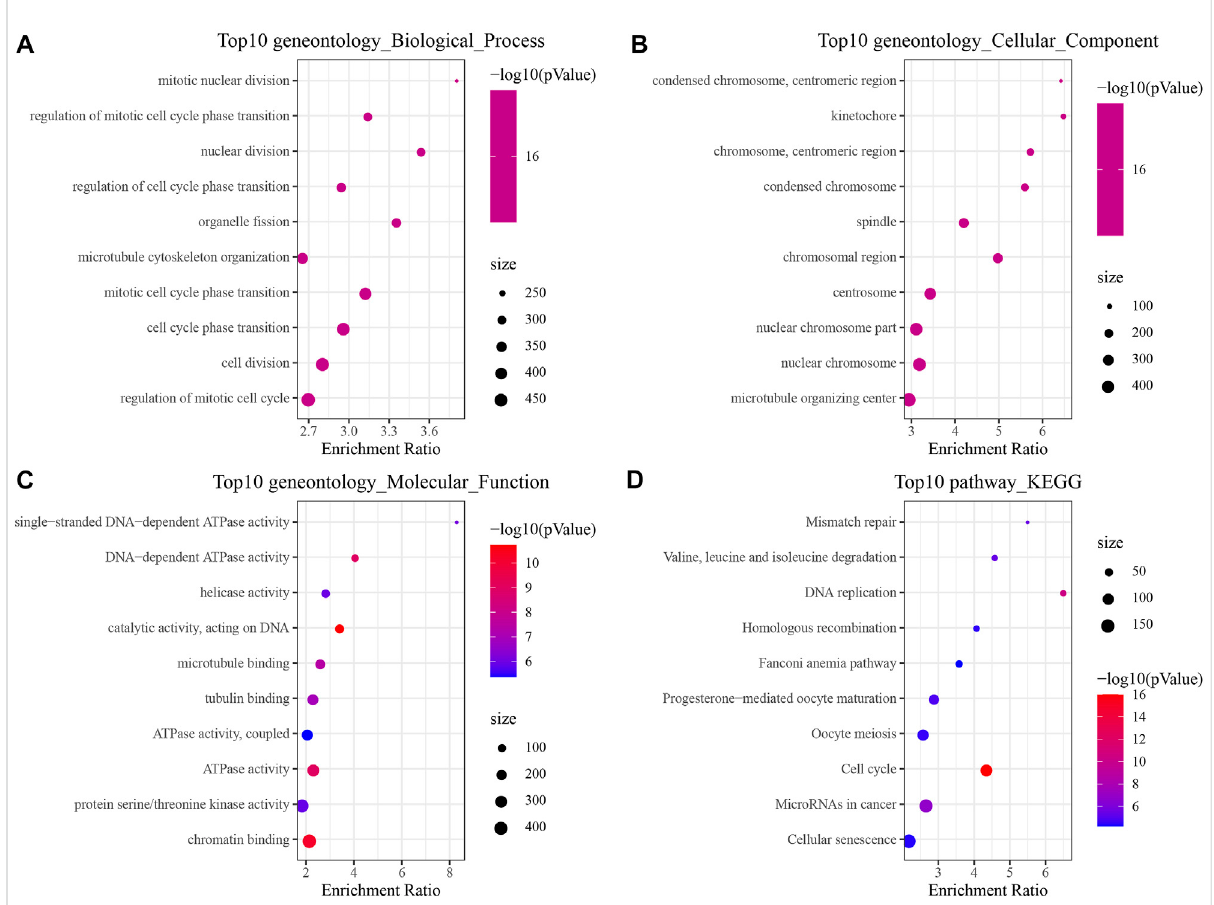
FIGURE 1 The results of functional enrichment analysis of HCCDB18. (A) BP annotation map of DEGs between HBV and non-HBV patients; (B) CC annotation map of DEGs between HBV and non-HBV patients; (C) MF annotation map of DEGs between HBV infected and non-HBV infected patients; (D) KEGG annotation map of DEGs between HBV and non-HBV